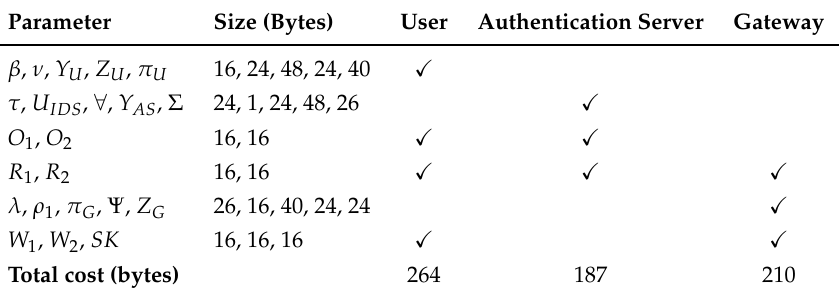
Table 3. Storage cost of proposed